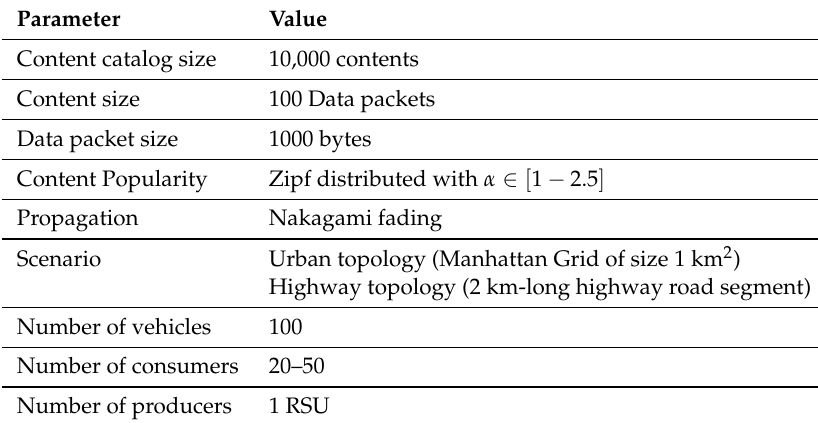
Table 3. Main simulation